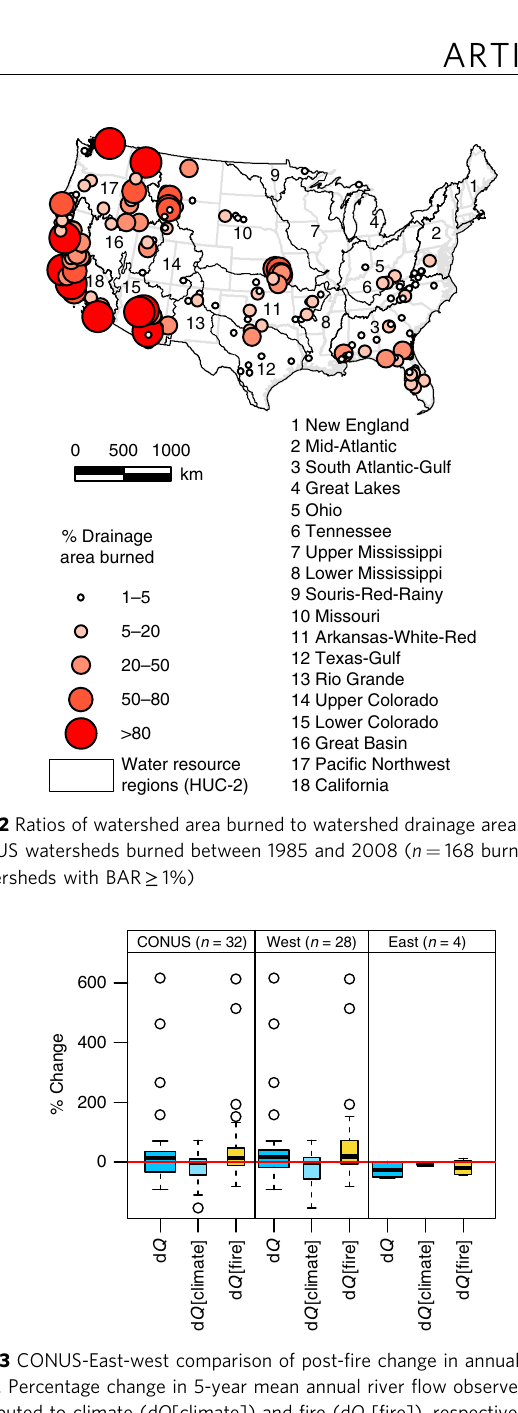
trends masked the enhancing impact of wild fi re on river fl ow.